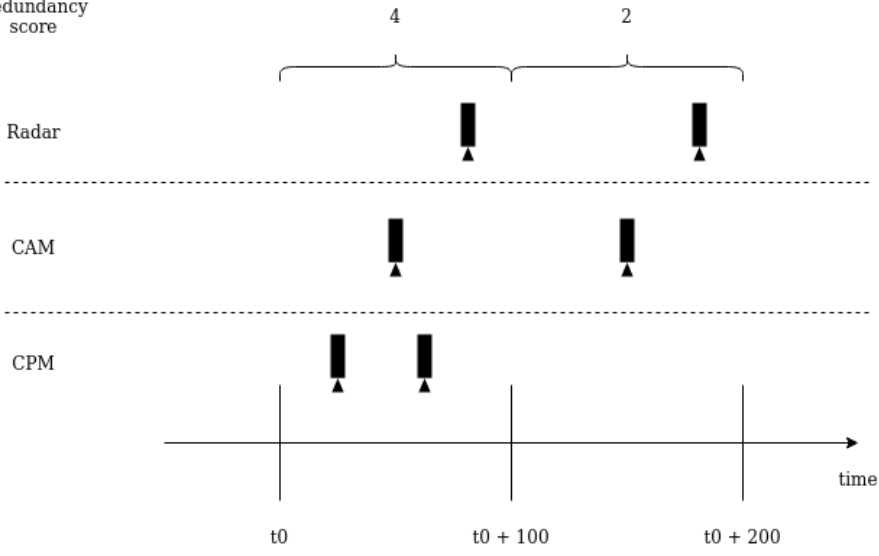
Figure 2. Redundancy score explanation. The camera icons show distinct perceptions about a particular remote vehicle with different sensor